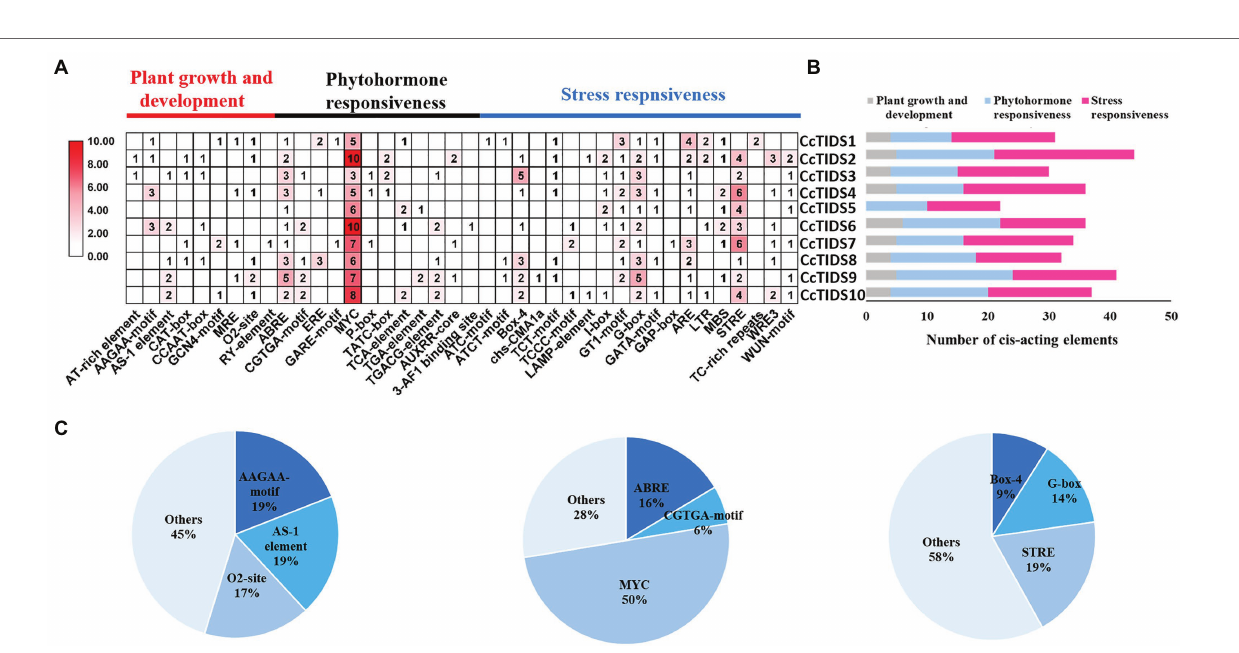
FIGURE 4 | (A) The number of cis-acting elements in each C. camphora (Cc)TIDS gene, indicated by the intensity of the red color and numbers in the grid. (B) Histograms indicating the number of cis-acting elements in each CcTIDS gene with functions in plant growth and development, phytohormone responsiveness, or stress responsiveness. (C) Pie charts showing the ratio of different cis-acting elements in each structural